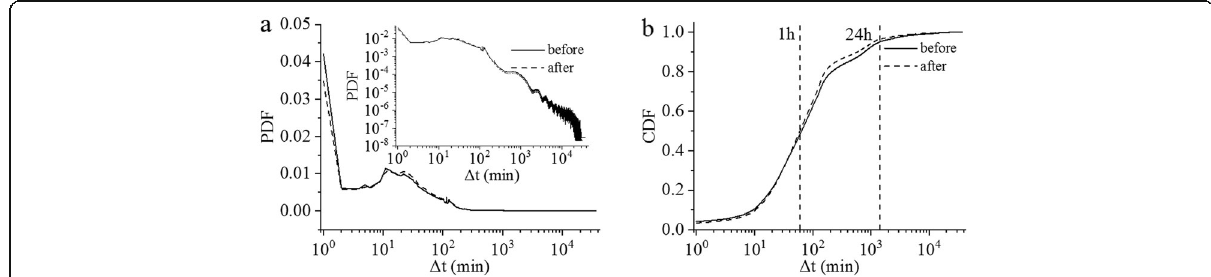
Fig. 9 Time interval between stays distribution before and after using the heuristic strategies. a Probability distribution. b Cumulative distribution